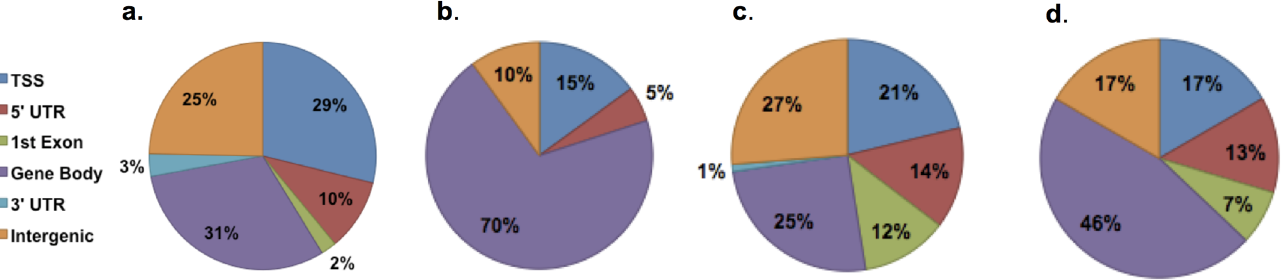
Fig 3. Gene regulatory regions of probe sites included on the Infinium 450K Human Methylation Bead Chip. TSS = Translational Start Site; UTR: Untranslated Region. a: Reference distribution of all probe sites included on the array. b, c and d: Distribution of probe site with AVDM > 10% and p < 0.001. b: All pairs c. Male offspring pairs. d. Female offspring